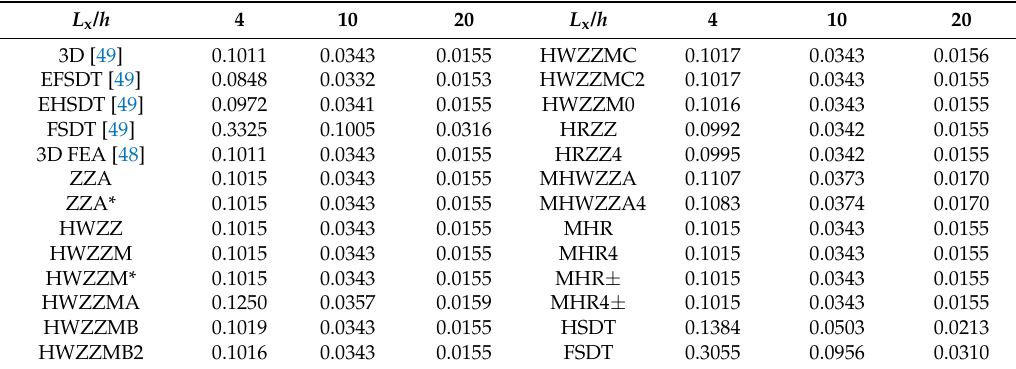
Table 7. Normalized fundamental frequencies, case